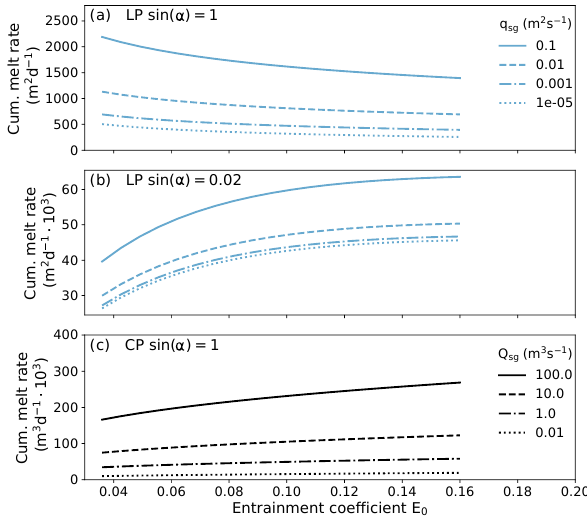
Figure 6. Cumulative melt rates of the different plume models as a function of entrainment parameter E 0 for four different discharge values. The cumulative melt rate is depicted for (a) LP of a tidewater glacier (sin (α) = 1), (b) LP of a long floating tongue and (c) CP of a tidewater glacier. For the LP model for sin (α) = 1 a higher E 0 leads to lower cumulative melting opposite to the other two cases.